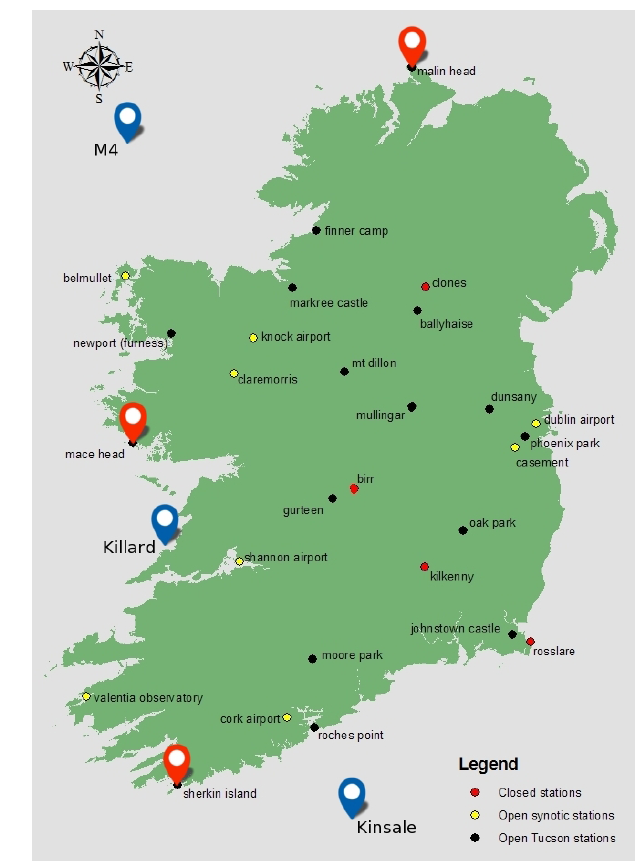
Figure 1. Map of Met Éireann stations and the location of the obser- vations of wave and wind parameters used in this study. The location of the wave buoys used for model validation, Kinsale Gas Platform, Killard and the M4 buoy, are marked with blue pins. The location of the three TUCSON coastal stations, Sherkin Island, Mace Head and Malin Head, are marked with red